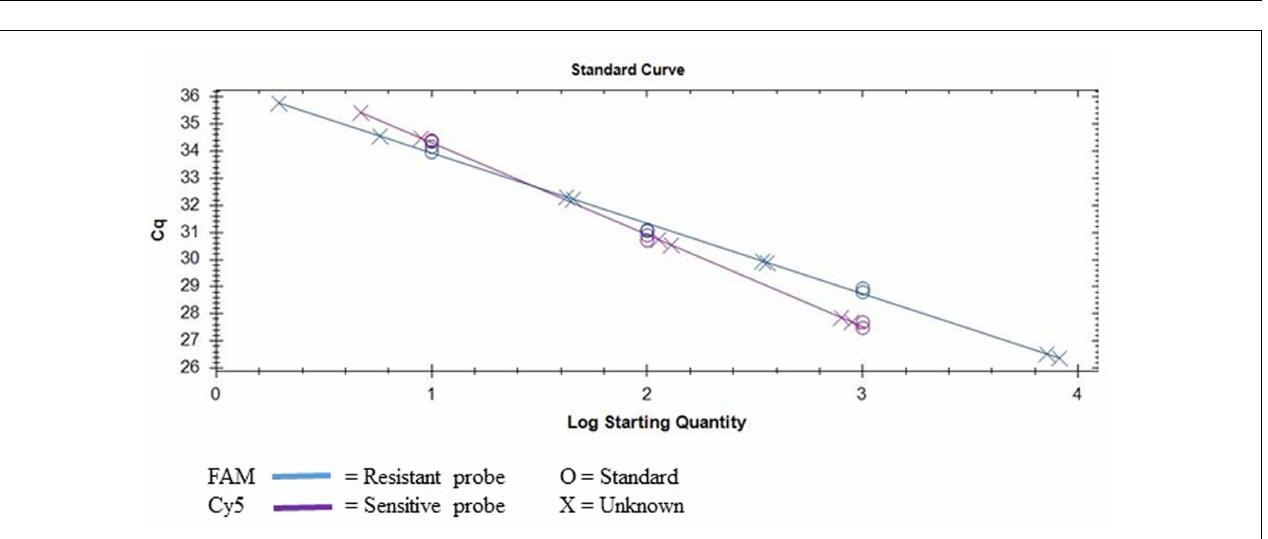
FIGURE 4 | Standard curve obtained by using the multiplex SNP TaqMan assay to detect the G143A mutation in D. rabiei isolates collected from Montana.